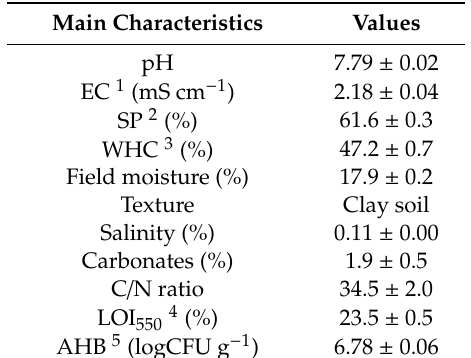
Table 2. Agronomic parameters of the uncontaminated